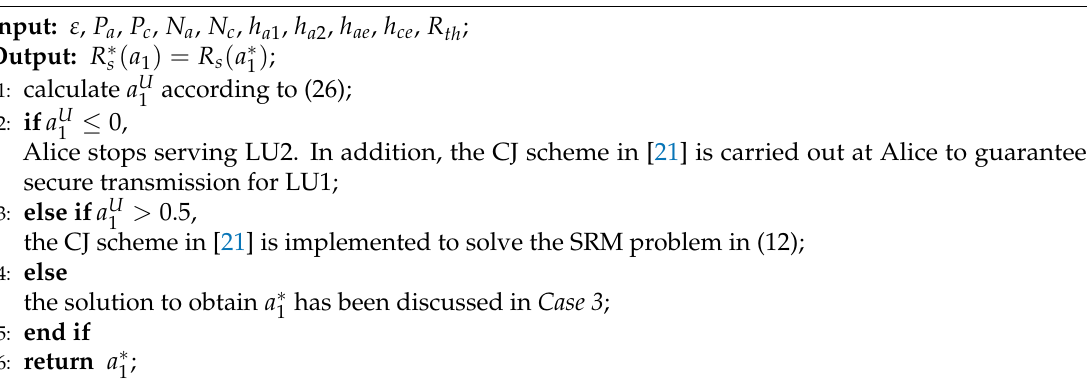
Algorithm 1 Solution to the SRM problem in